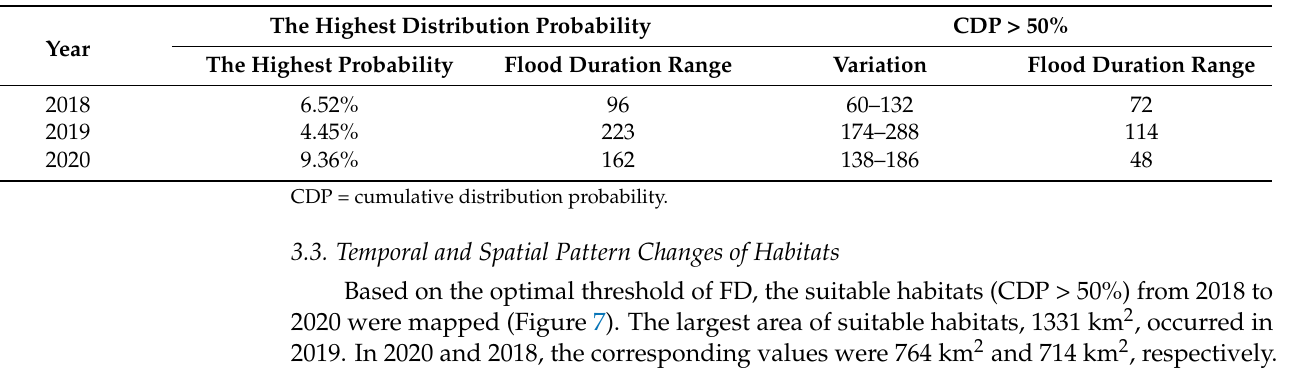
Table 3. Response threshold of geese to flood duration (FD) in different hydrological